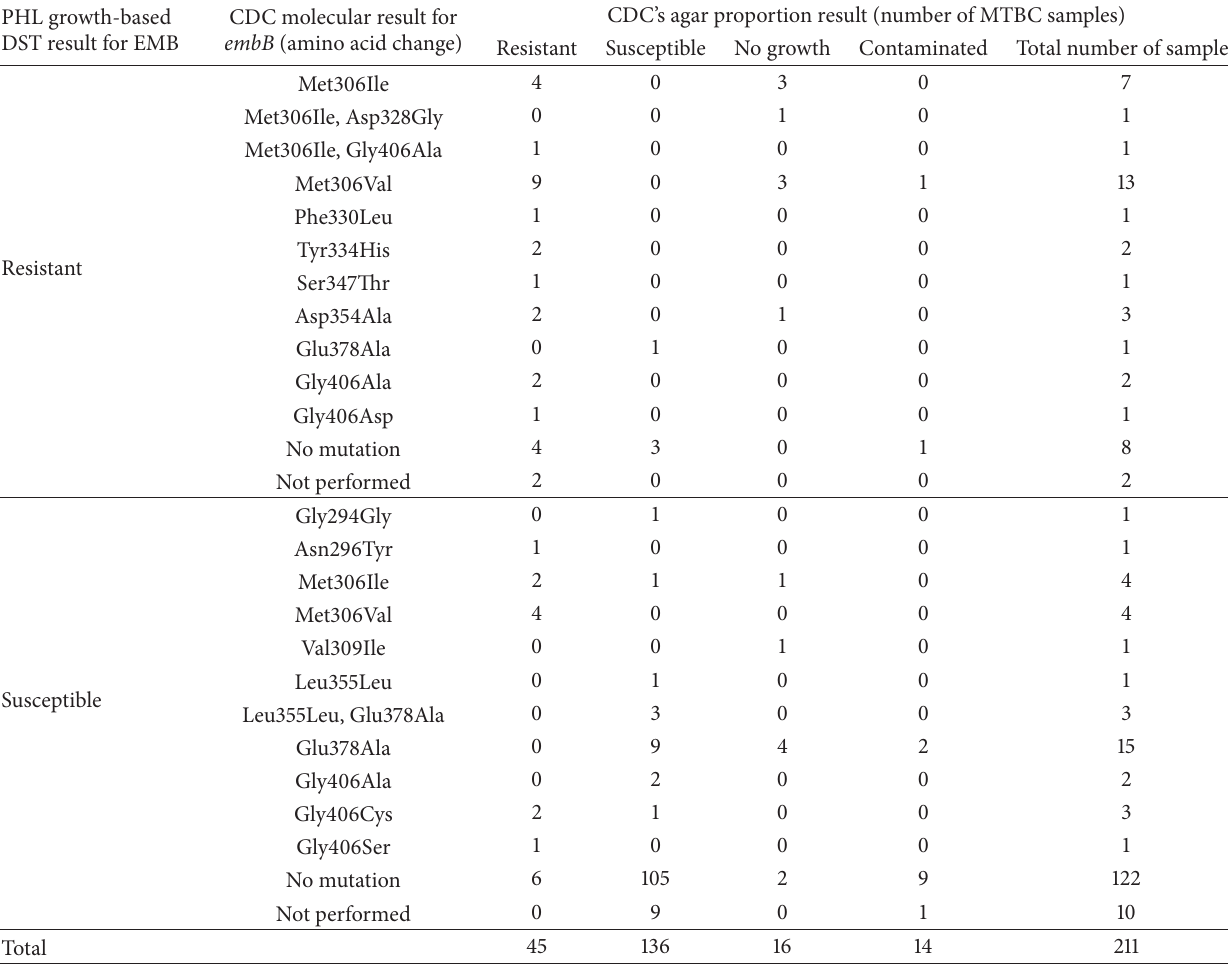
Table 1: Comparison of PHL growth-based DST with CDC’s molecular detection and growth-based DST results for EMB. PHL growth-based